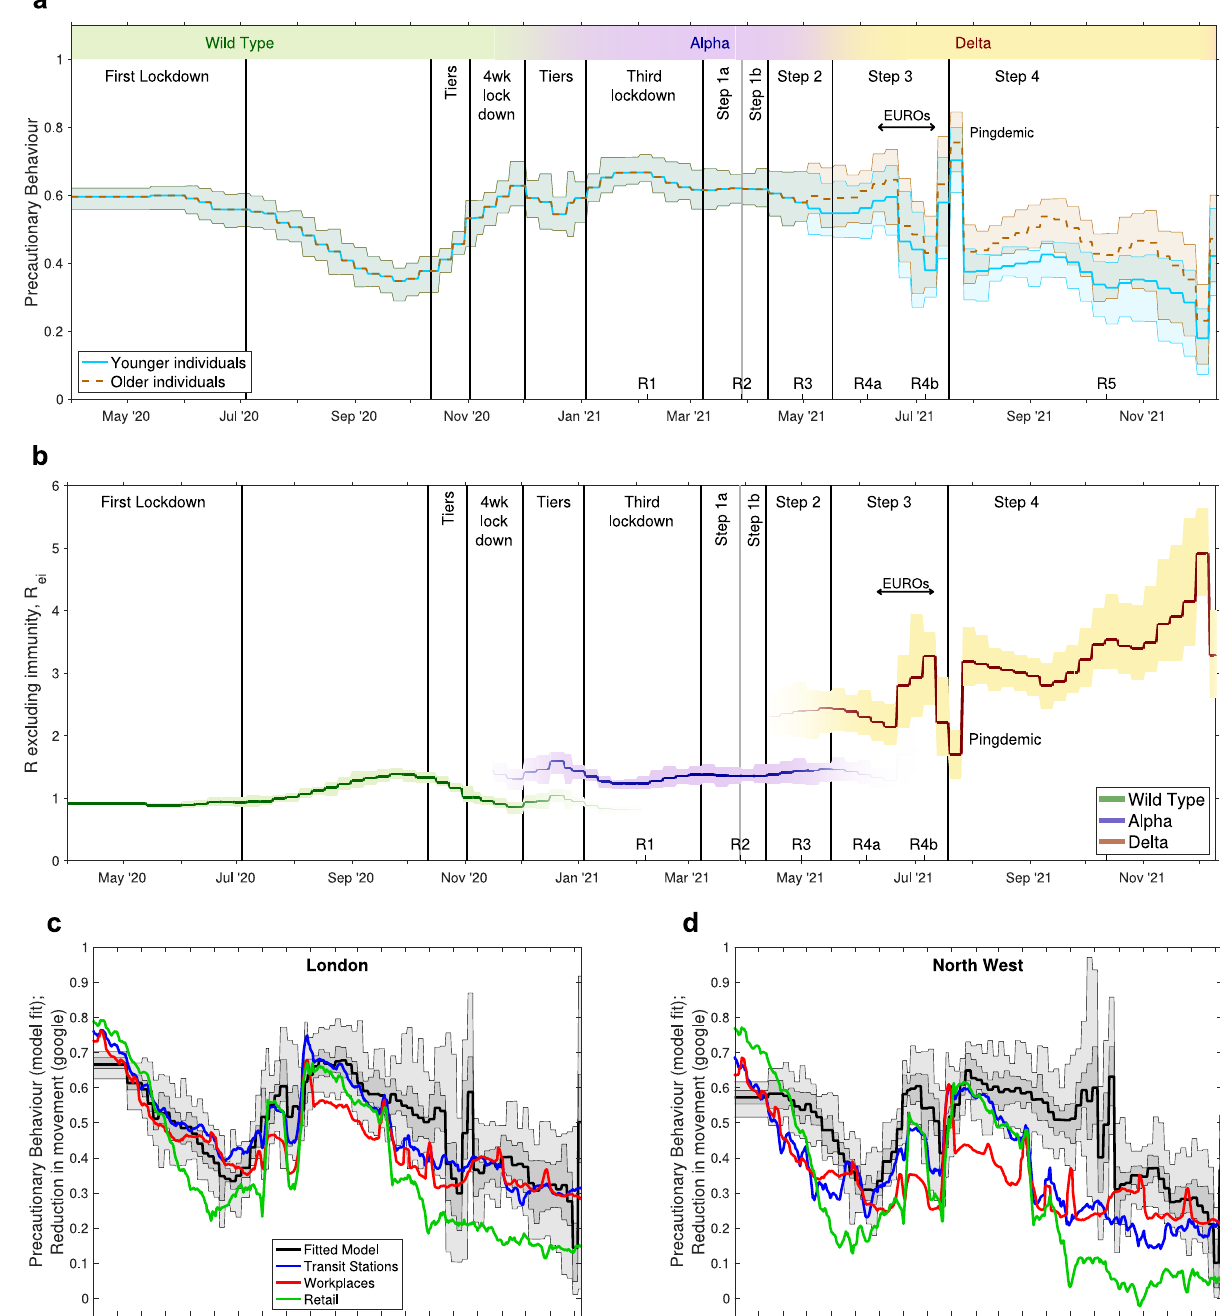
Fig.1|Changesintheinferreddynamicsovertime.a Theinferredprecautionary behaviour in England from April 2020 to December 2021; younger individuals are under 40, older individuals are over 65, while those in between are a linear extra- polation. b The resultant changes to R excluding immunity for the three main variants. c , d A comparison between fi tted precautionary behaviour and Google movement records 27 in two NHS regions. Vertical lines indicate the time of key changes to the control measures. Labels are key moments from the pandemic in England: Lockdowns are nationwide restrictions on movement and social mixing; Tiers are localised restrictions of varying degrees; Steps are as